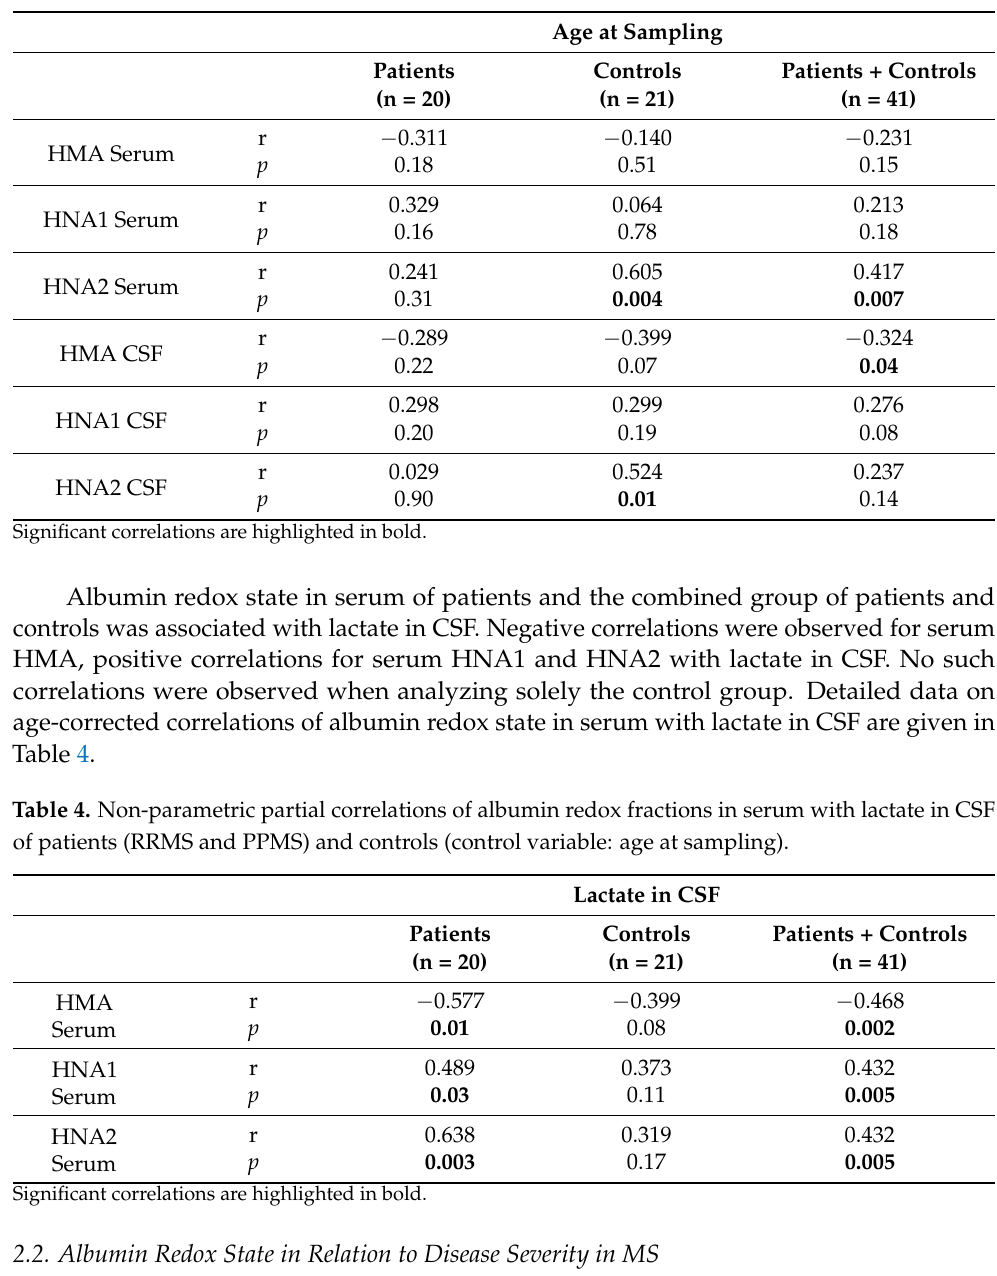
Table 3. Spearman correlations of albumin redox fractions in serum and CSF of patients (RRMS and PPMS) and controls with the age at sampling.